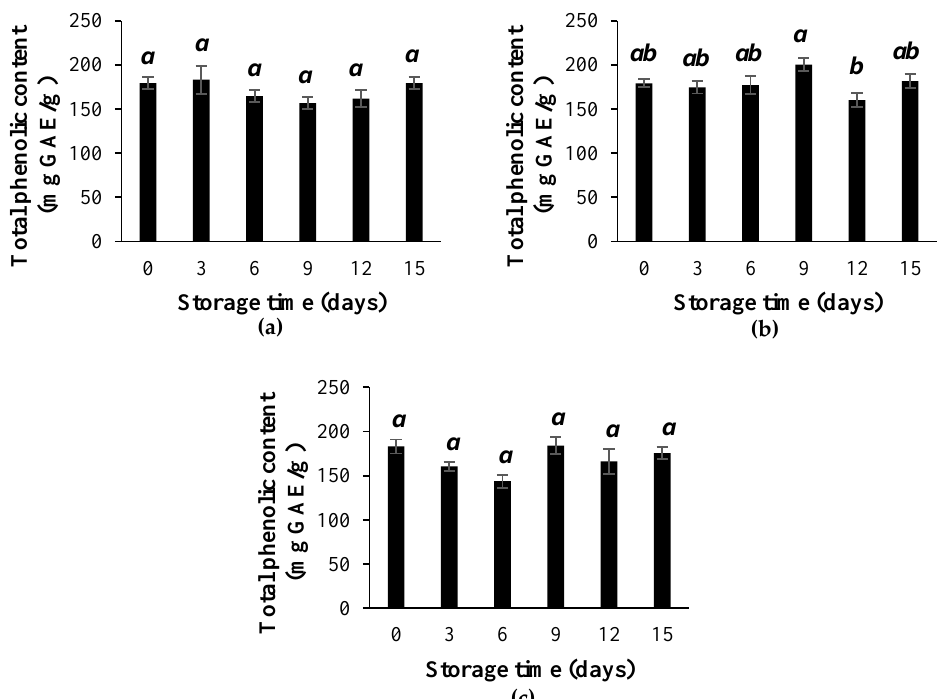
Figure 7. E ff ects of storage time on the total phenolic content of black tea ( a ) 4 ◦ C, ( b ) 9 ◦ C and ( c ) 25 ◦ C. Figure 7. Effects of storage time on the total phenolic content of black tea ( a ) 4 °C, ( b ) 9 °C and ( c ) 25 Means with the same capital alphabetical letters are not significantly di ff erent according to the results °C. Means with the same capital alphabetical letters are not significantly different according to the of the Tukey’s results of the Tukey’s tes t.